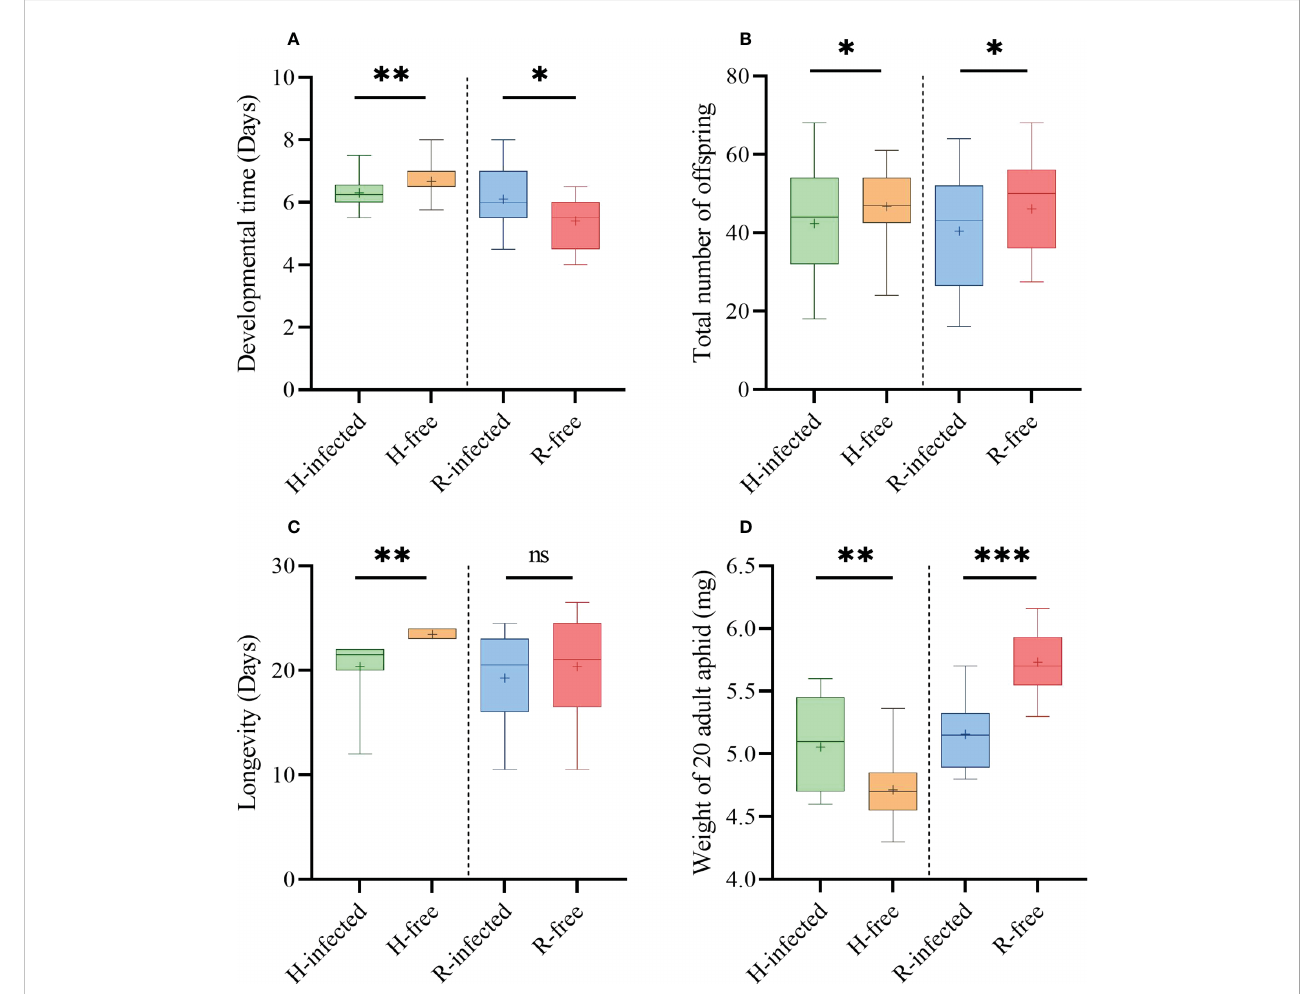
FIGURE 4 Fitness indices of different aphid strains. (A) Aphid developmental time. (B) Aphid total number of offspring. (C) Aphid longevity. (D) Weight of 20 newly matured aphid adults. Box plots: boxes, interquartile range (IQR); whiskers, minimum and maximum values; lines inside the boxes, median value; cross, mean value. The asterisk indicates signi fi cant differences based on the t -test for two-sample comparison: * P <0.05, ** P <0.01, *** P <0.001, and ns nonsigni fi cant.